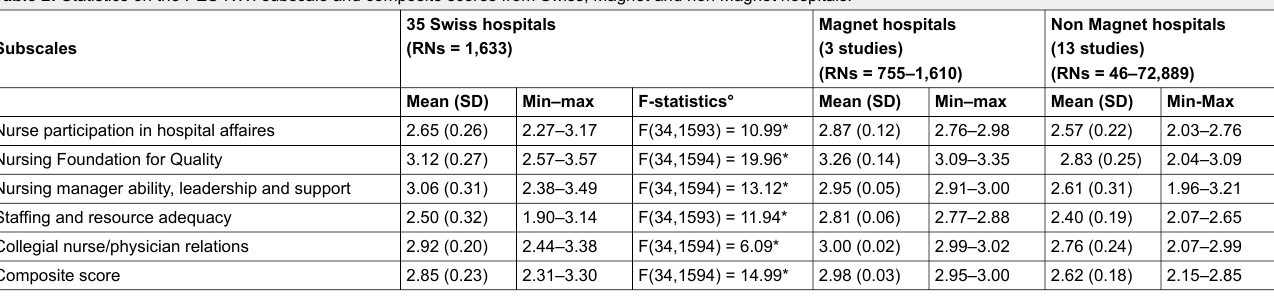
Table 2: Statistics on the PES-NWI subscale and composite scores from Swiss, Magnet and non Magnet hospitals. Subscales